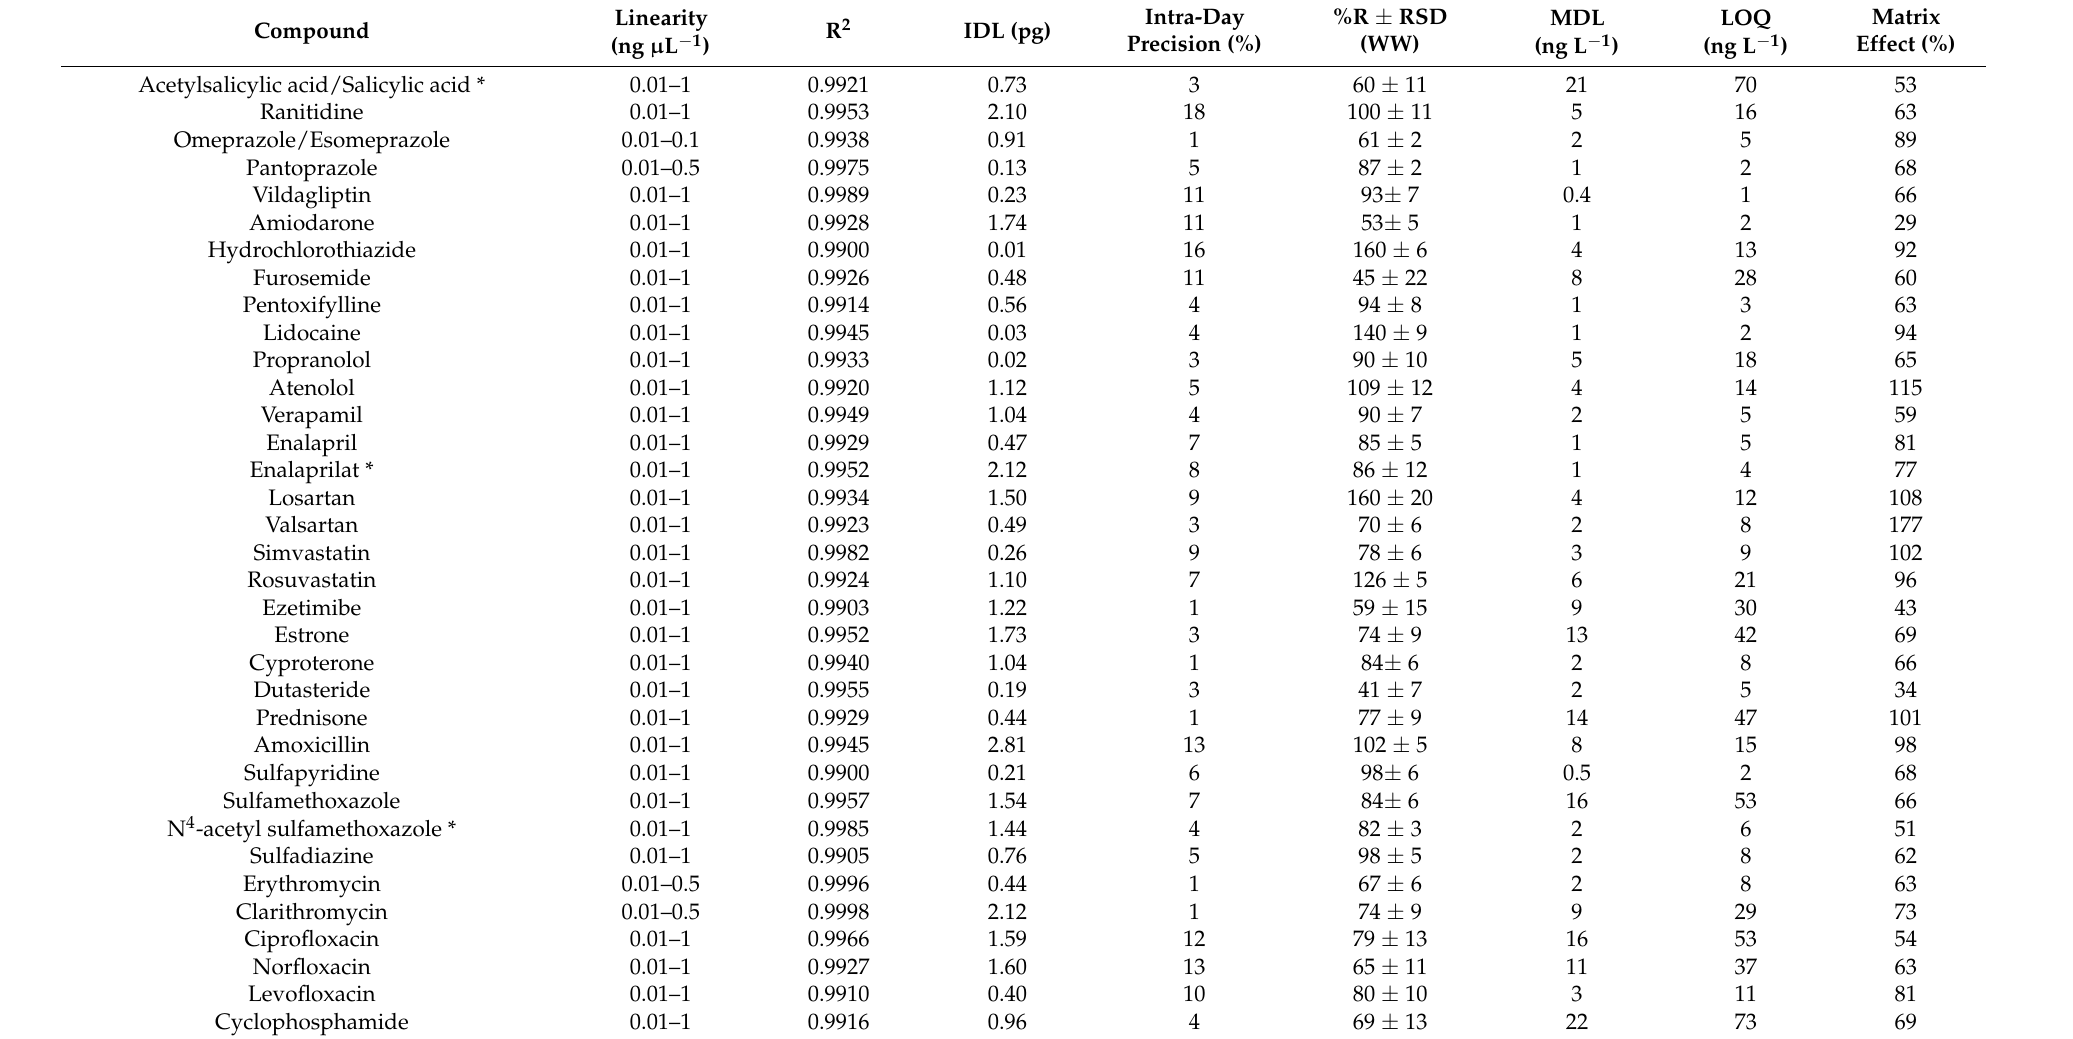
Table 2. Quality parameters obtained for 76 compounds ordered following de ATC code for the pharmaceuticals, metabolites (*) and transformation product (**).